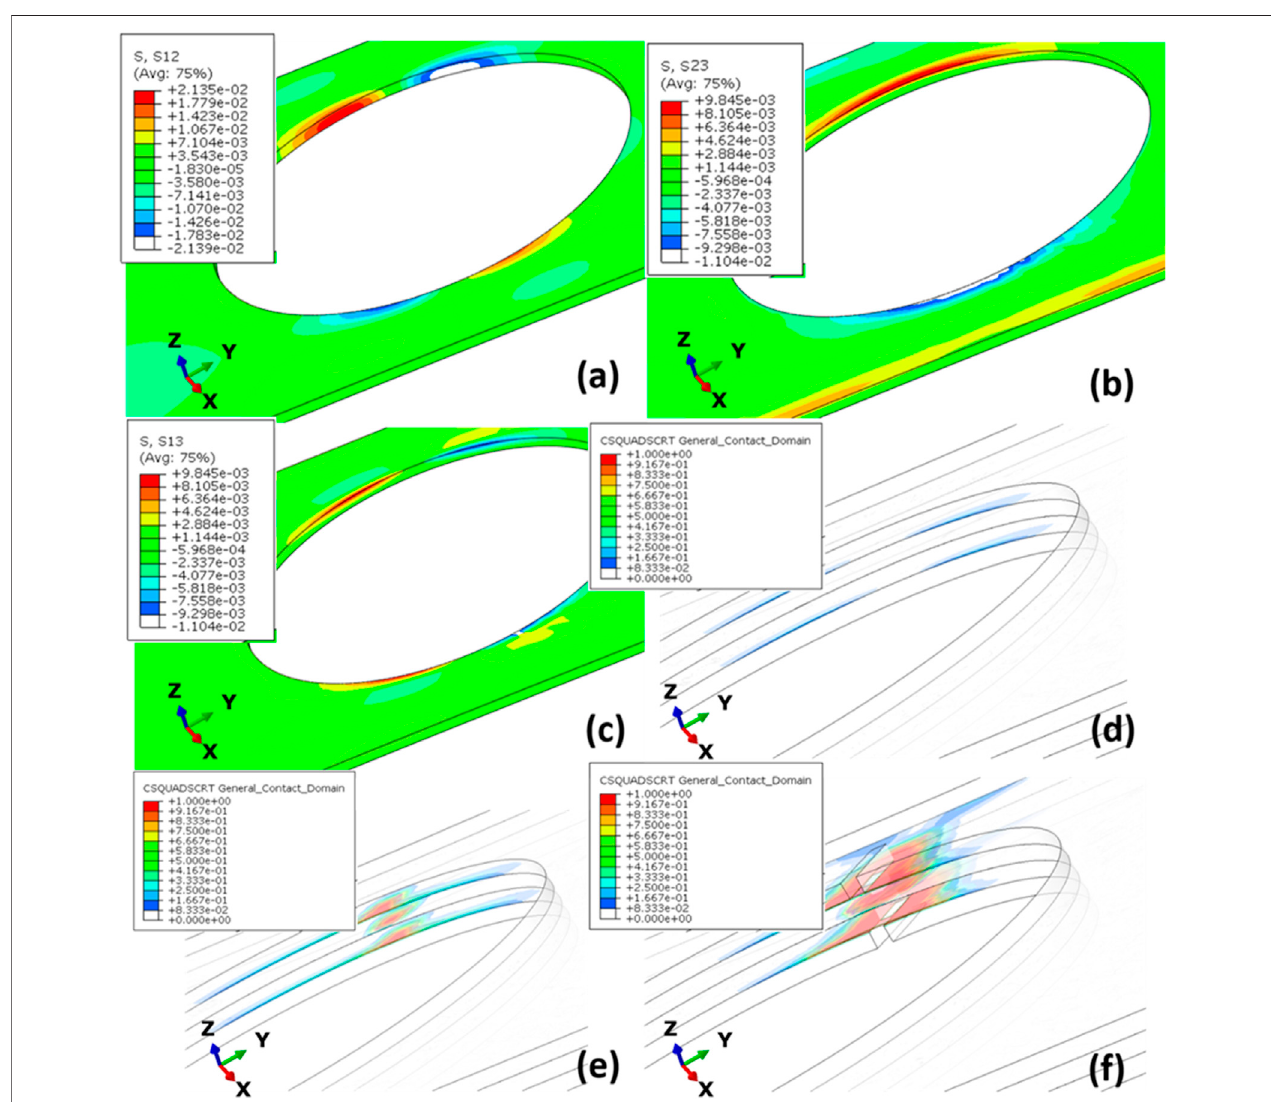
FIGURE11| Delaminationevolution: (A) in-planeshearstressattheinterfacesbetweenthe0 o plyand the45 o ply, (B,C) out-of-planeshearstressbetweenthe0 o ply and the 45 o ply, (D) interface damage starts when the external tensile stress is 45 MPa, (E) delamination starts when 0 o plies start to damage (tensile stress σ (cid:1) 90 MPa), and (F) crack grows accompanied with massive delamination.